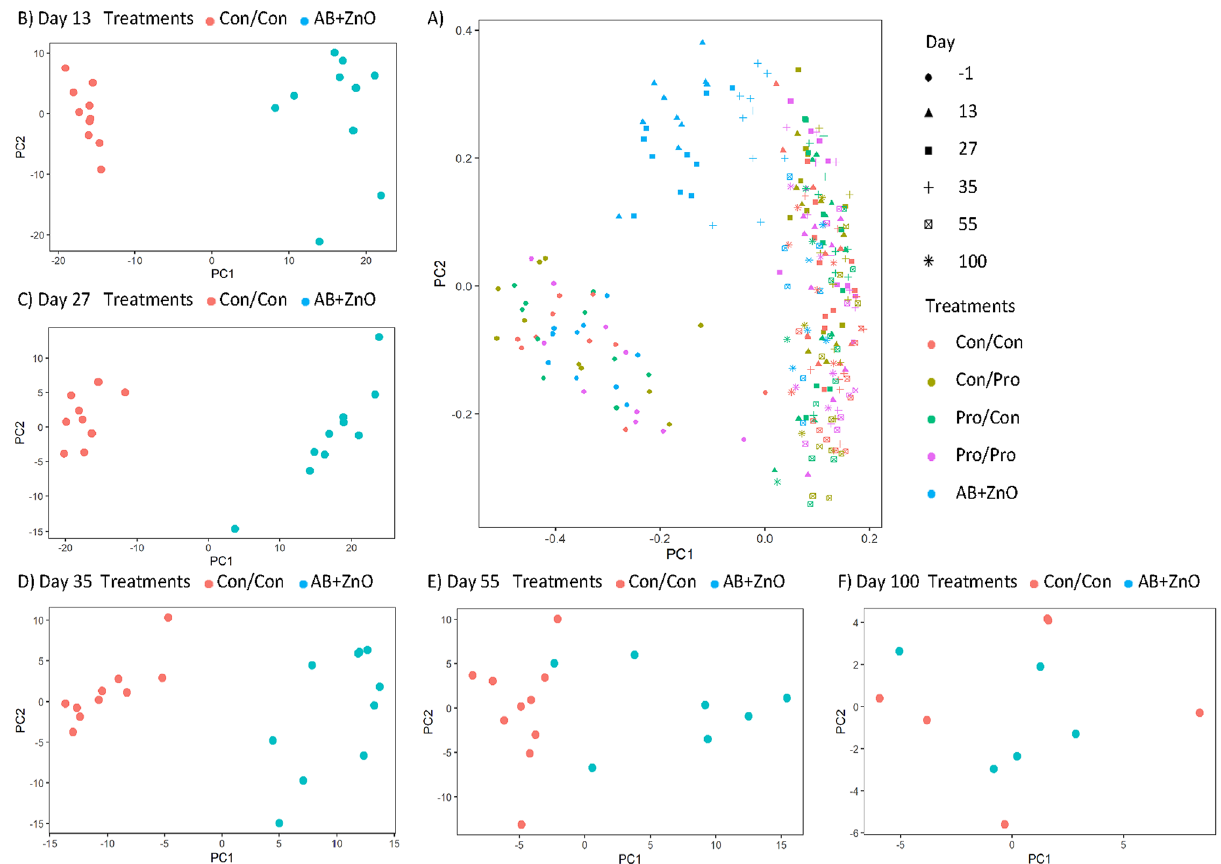
Figure 2. ( A ) PCoA plot of the Bray Curtis distances of the faecal microbiota of pigs on all five treatments across all sampling time points. ( B – F ) PCA plots of the intergroup variation for amplicon sequence variant (ASV) representation at the genus level of the faecal microbiota of Con/Con and AB + ZnO treatments during five time points post-weaning (PW): ( B ) Day 13 PW, ( C ) Day 27 PW, ( D ) Day 35 PW, ( E ) Day 55 PW, and ( F ) Day 100 PW. Shapes indicate the day PW that pigs were sampled. Colours indicate the treatments as follows (1st stage weaning period/2nd stage weaning period): Con/Con, Con/Pro, Pro/Con, Pro/Pro, and AB + ZnO; where Con = control, Pro = probiotic and AB + ZnO = antibiotic +